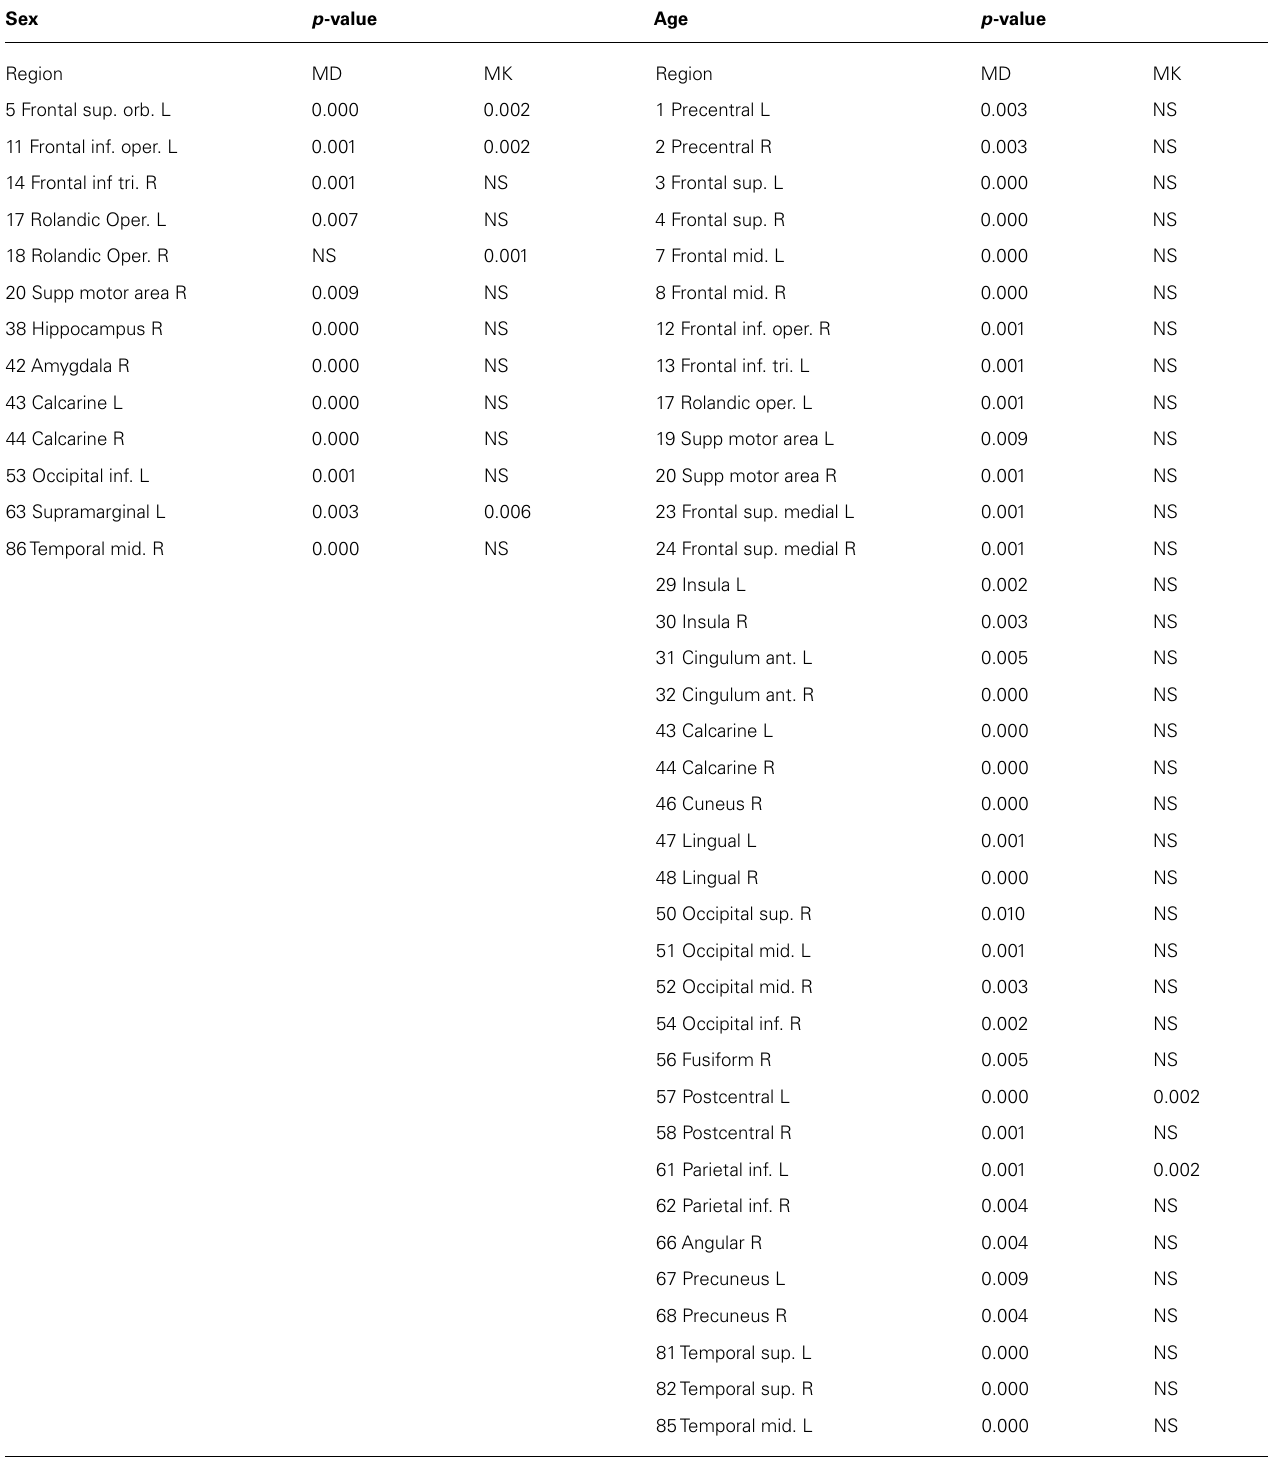
Table 2 | Regions with significance for the sex by age interaction.